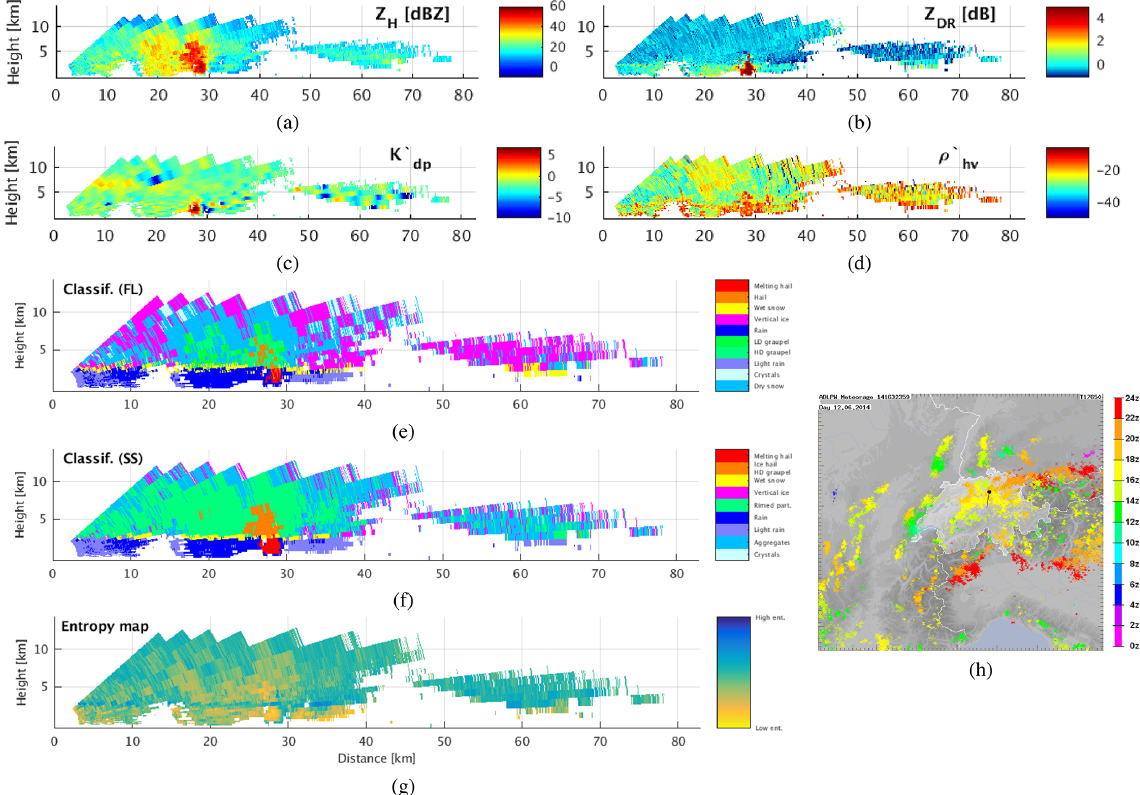
Figure 11. Hail continuity and vertical ice detection, 17:30, 12 June 2014. Albis reconstructed RHI profile, 187 ◦ azimuth: (a) Z H , (b) Z DR , (c) K (cid:48) , (d) ρ (cid:48) , (e) FL classification, (f) SS classification, (g) SS measure of entropy. (h) Lightning distribution by time (cloud to ground ± dp hv and intra-clouds indicated with an X) ©Météorage.